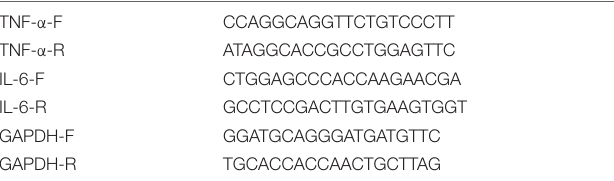
TABLE 2 | Expression of pro-inflammatory